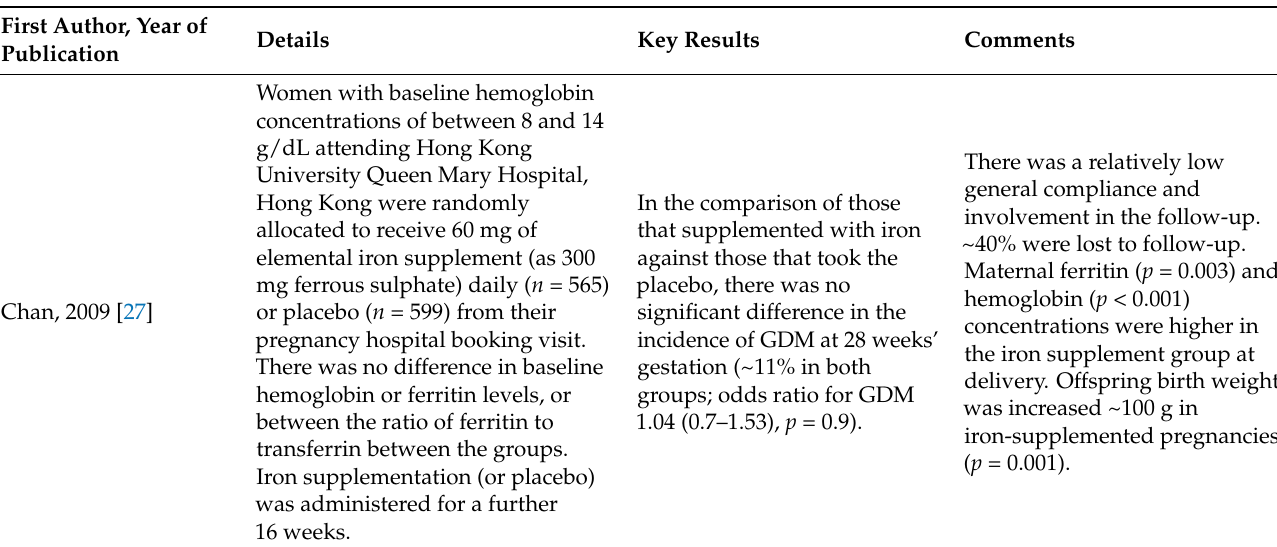
Table 2. Randomized controlled trials that sought associations between iron supplementation in pregnancy and